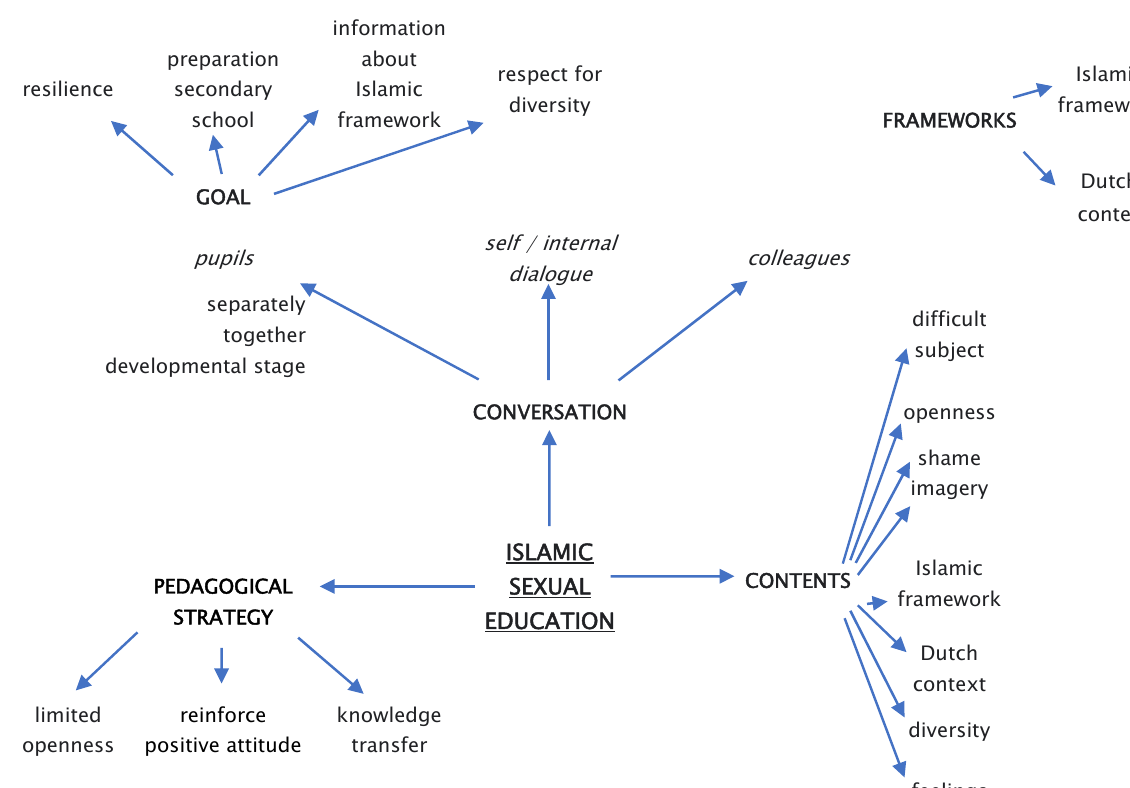
Figure 1. Tree structure with met key concepts of sexual education.